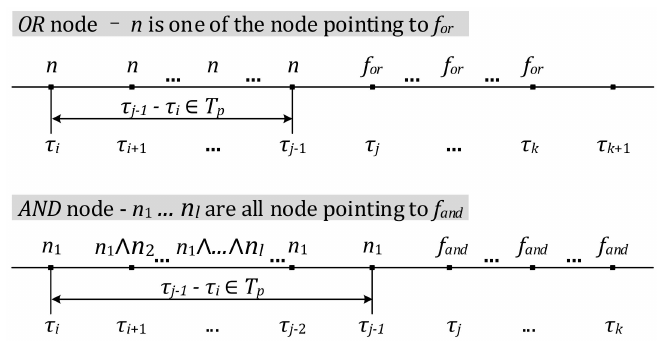
Figure 6. Conditions for a trace π ’ of a PDSS to satisfying an OR/AND node on a